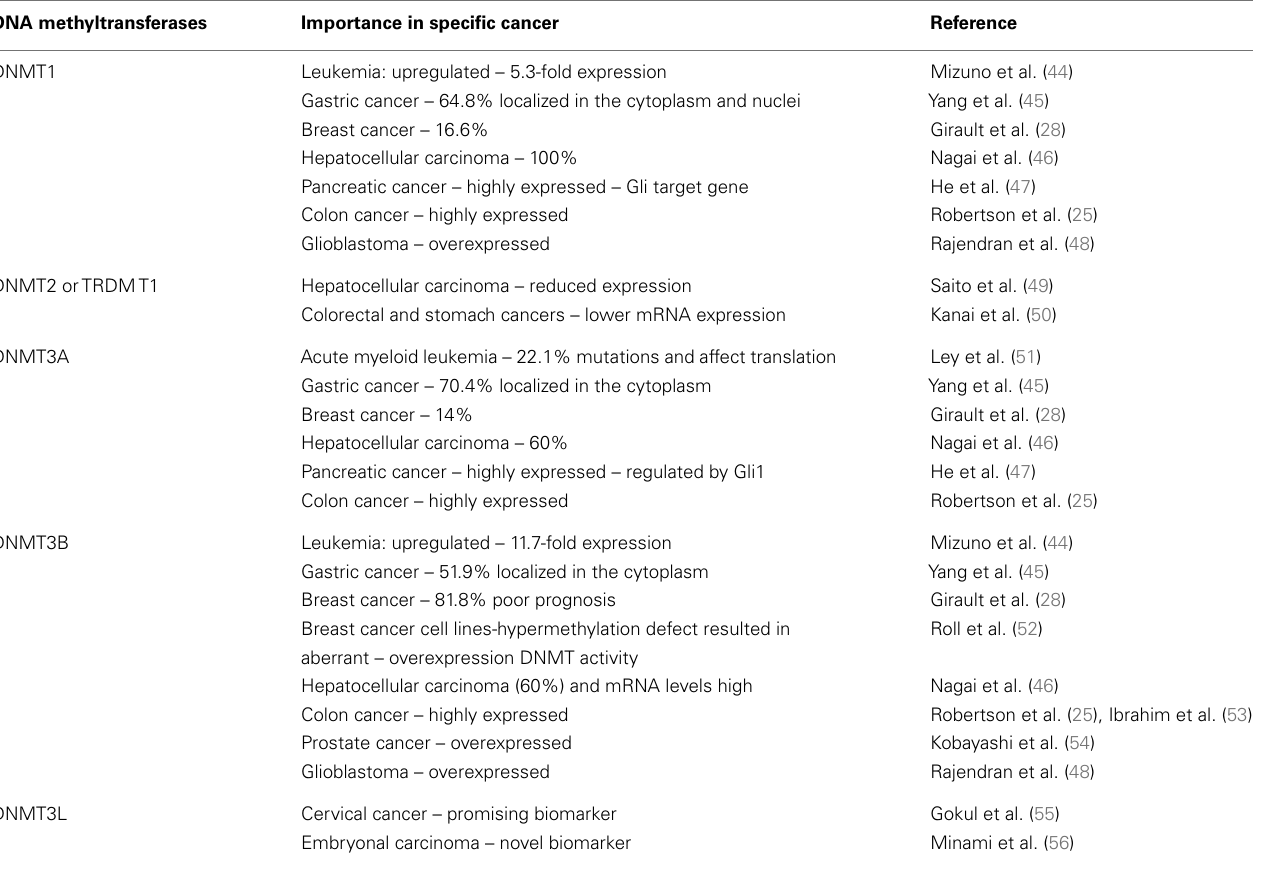
Table 1 | DNA methyltransferases and its importance in specific cancer